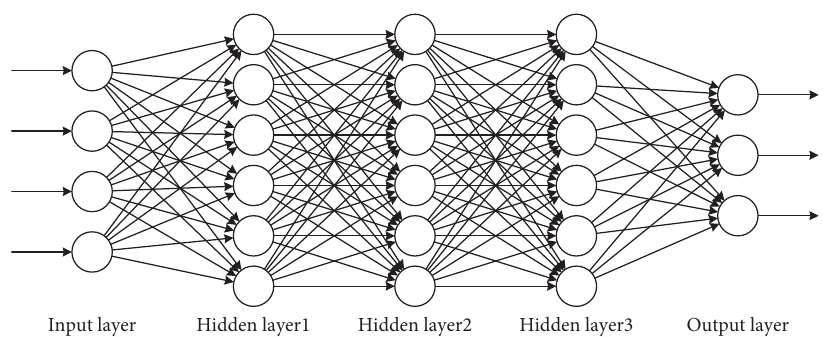
Figure 5: Convolutional neural